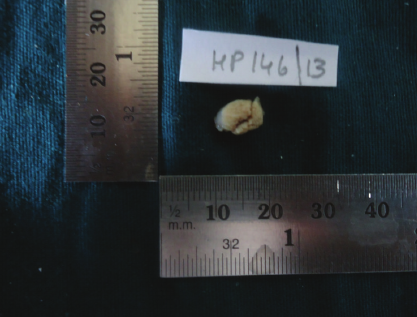
Figure 6: Showing the lesion after